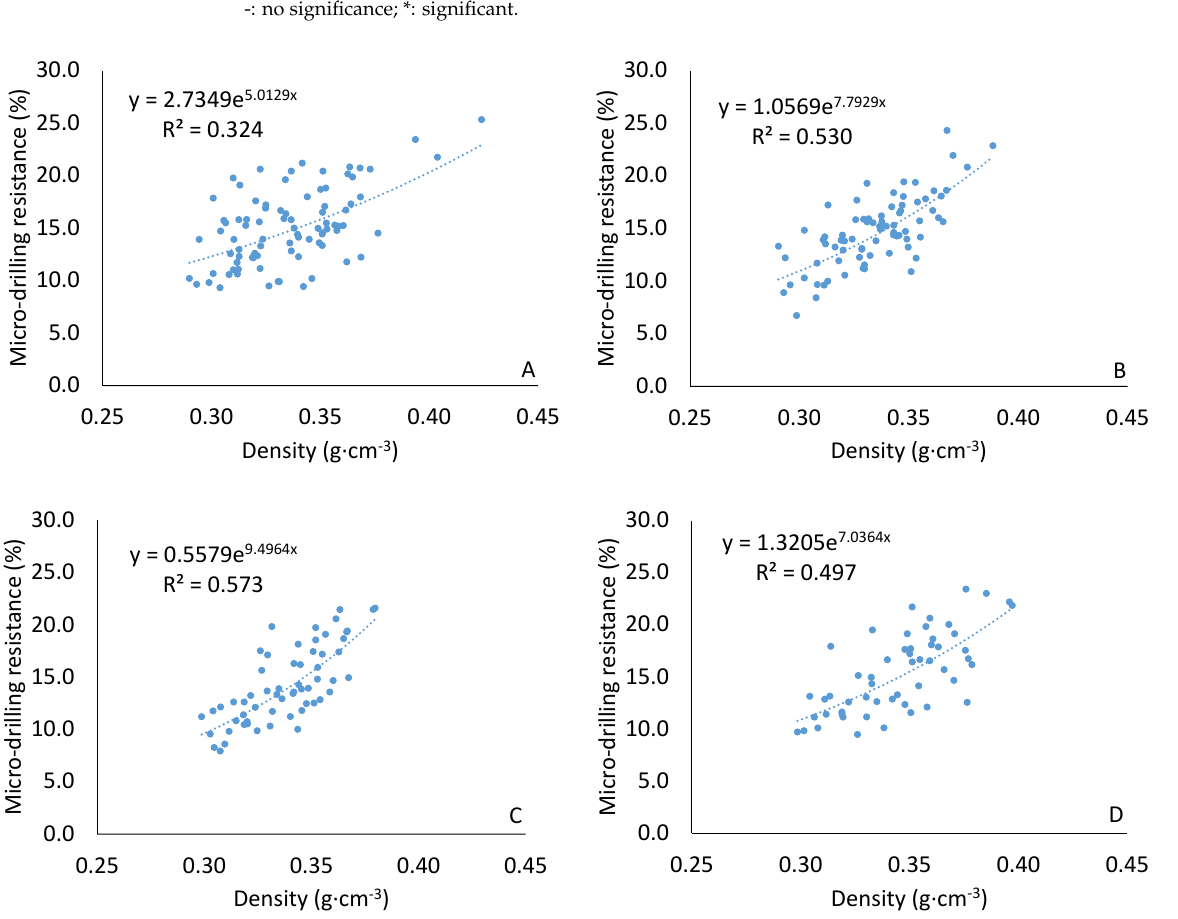
Figure 4. Relationship between wood density and microdrilling resistance indicated by Resisto- graph device ( A ) V1, 2500; ( B ) V2, 3330; ( C ) V3, 5000; ( D ) V4, 7510 trees·ha − 1 .